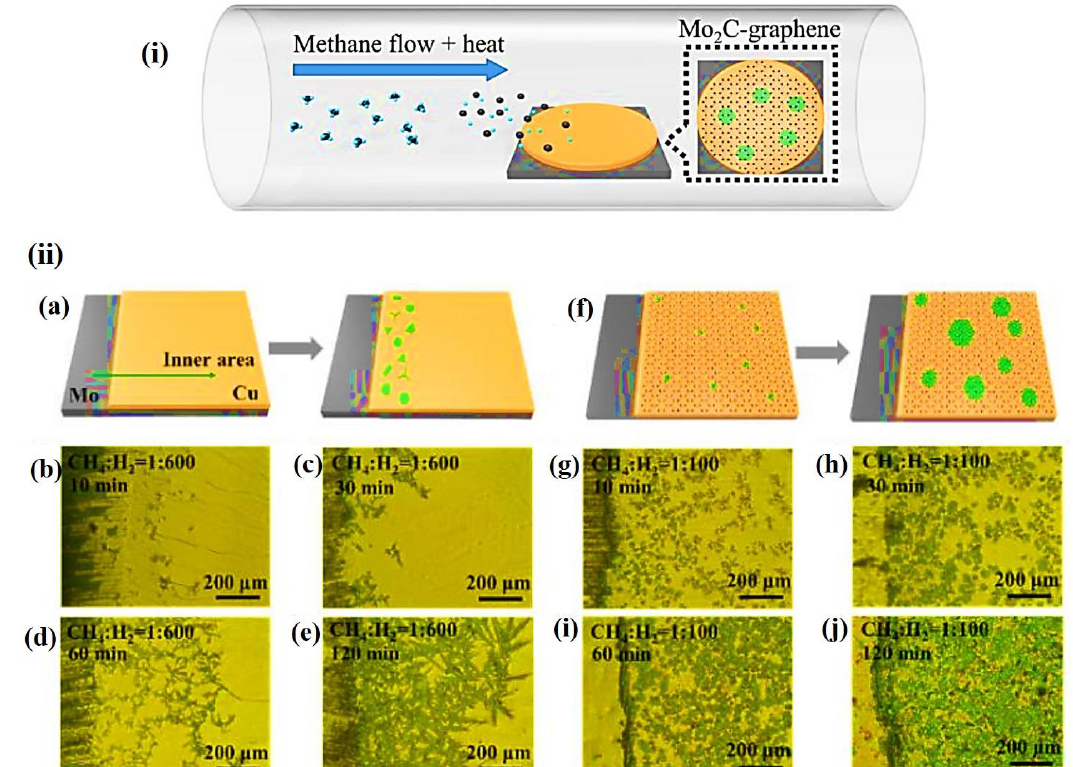
Figure 3. ( a ) Typical representation for the formation of Mo 2 C-graphene over a Cu/Mo substrate under various flow rates (low and high) of CH 4 to H 2. ( ii ) ( b – e ) Optical microscope image of Mo 2 C over a Cu/Mo substrate under various flow rates (low and high) of CH 4 to H 2 at different time intervals of ( b ) 10 min, ( c ) 30 min, ( d ) 60 min, and ( e ) 120 min, ( f ) formation of Mo 2 C-graphene over a Cu/Mo substrate at high flow rate, ( g – j ) Optical microscope image of Mo 2 C-graphene over a Cu/Mo substrate under various flow rates (low and high) of CH 4 to H 2 at different time intervals of ( g ) 10 min, ( h ) 30 min, ( i ) 60 min, and ( j ) 120 min [16]. Hot filament CVD (HF-CVD) has been used to grow vertically aligned graphene na-